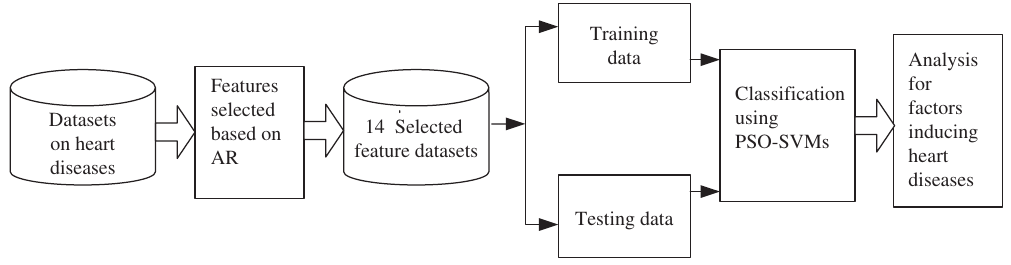
Figure 1: Detection of Heart Diseases Using AR-PSO-SVM. Cleveland Heart Disease Data